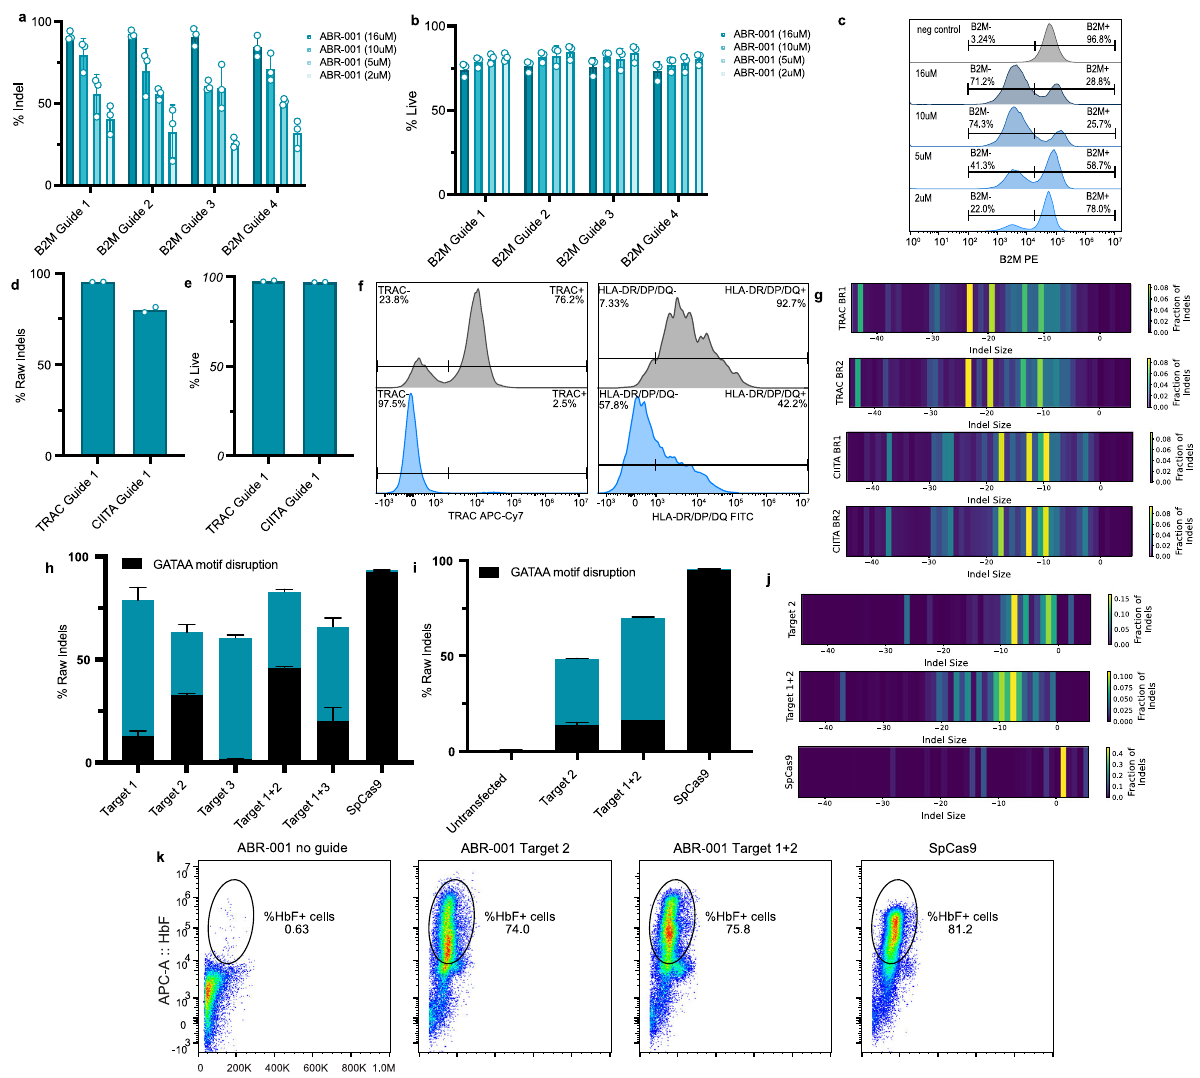
Fig. 3 ABR-001 enables ex vivo editing of human primary cells. a , b Indel activity ( a ) and viability ( b ) of human CD3 + T cells following delivery of ABR- 001 RNPs with 4 different B2M-targeting guides (B2M 1 – 4) at decreasing concentrations (16 µ M, 10 µ M, 5 µ M, and 2 µ M). Cell viability was measured using fl ow cytometry at 7 days post-electroporation. Bars represent the average of 3 donors (circles), with error bars representing the s.d.. c Representative histograms show B2M protein level knockdown at 7 days post-electroporation with ABR-001 RNP with B2M 1 guide at decreasing concentrations (16 µ M, 10 µ M, 5 µ M, and 2 µ M). Y-axes represent count normalized to mode. d Indel activity of CD3 + T cells following delivery of 16 µ M ABR-001 RNPs targeting TRAC and CIITA. Circles represent each of n = 2 bioreplicates. e Viability of CD3 + T cells following delivery of 16 µ M ABR-001 RNPs targeting TRAC and CIITA. Circles represent each of n = 2 bioreplicates. f Representative histograms show protein level knockdown at 7 days post-electroporation for TRAC and CIITA (HLA-DR/DP/DQ readout). Y -axes represent count normalized to mode. g Indel size was compared between two independent experiments (BR1 and BR2) of ABR-001 RNPs targeting TRAC and CIITA. The color scale indicates the fraction of indel reads at a given indel size. h Indel rates (teal) and % GATAA disruption (black) of multiplexed ABR-001 RNPs (16 µ M total concentration) or single SpCas9 RNP (5 µ M concentration) targeting the BCL11A enhancer, 72 h post-delivery into human CD34 + cells. Bars represent mean and error bars represent s.d. of n = 3 replicates. i Indel rates (teal) and % GATAA disruption (black) of ABR-001 RNPs (20 µ M total concentration) and SpCas9 RNP (5 µ M concentration) after delivery and 20 days of maturation in erythroid differentiation media. Bars represent mean and error bars represent s.d. of n = 3 replicates. j Indel pro fi les of ABR-001 RNP (target 2 and multiplex target1 + 2) and SpCas9 RNP targeting the BCL11A enhancer in human CD34 + cells. The color scale indicates the fraction of indel reads at a given indel size. k Representative fl ow cytometric analyses of edited CD34 + cells after delivery and 20 days of maturation in erythroid differentiation media. Source Data are provided as a Source Data fi